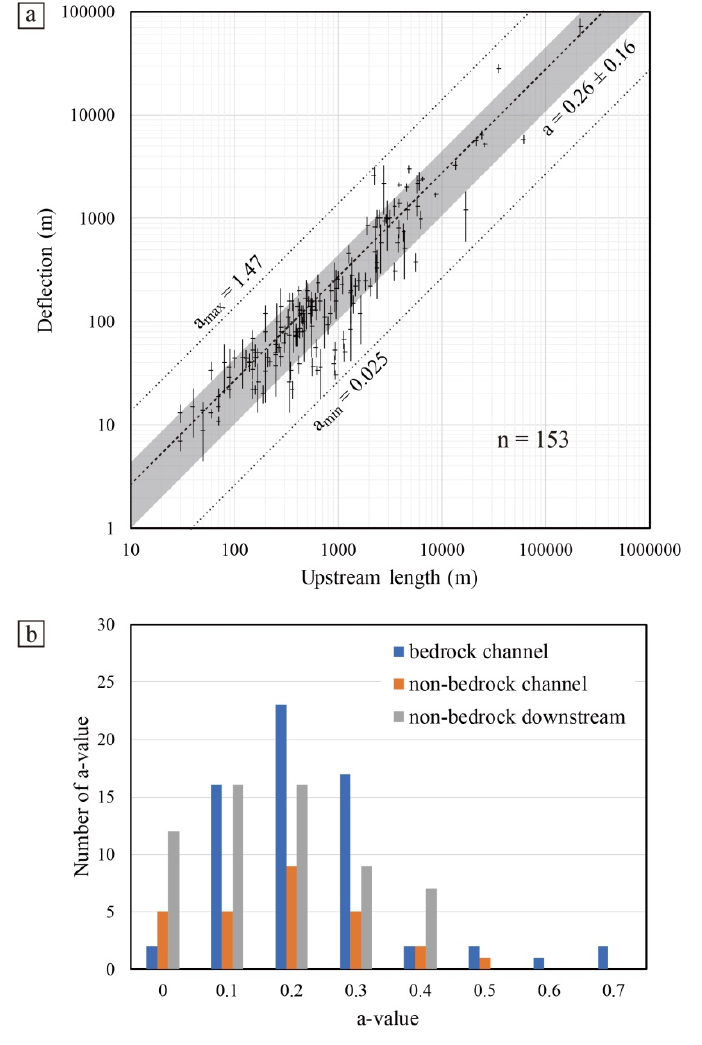
Figure 8. ( a ) Double logarithmic diagram showing the relationship between the deflection amount (D) and the upstream channel length (L) in the study area. The deflection amount D indicates a linear relationship with the upstream length of stream channel L. ( b ) Histograms show distribution of the a-value of the three types of channels (see Section 4 for detailed